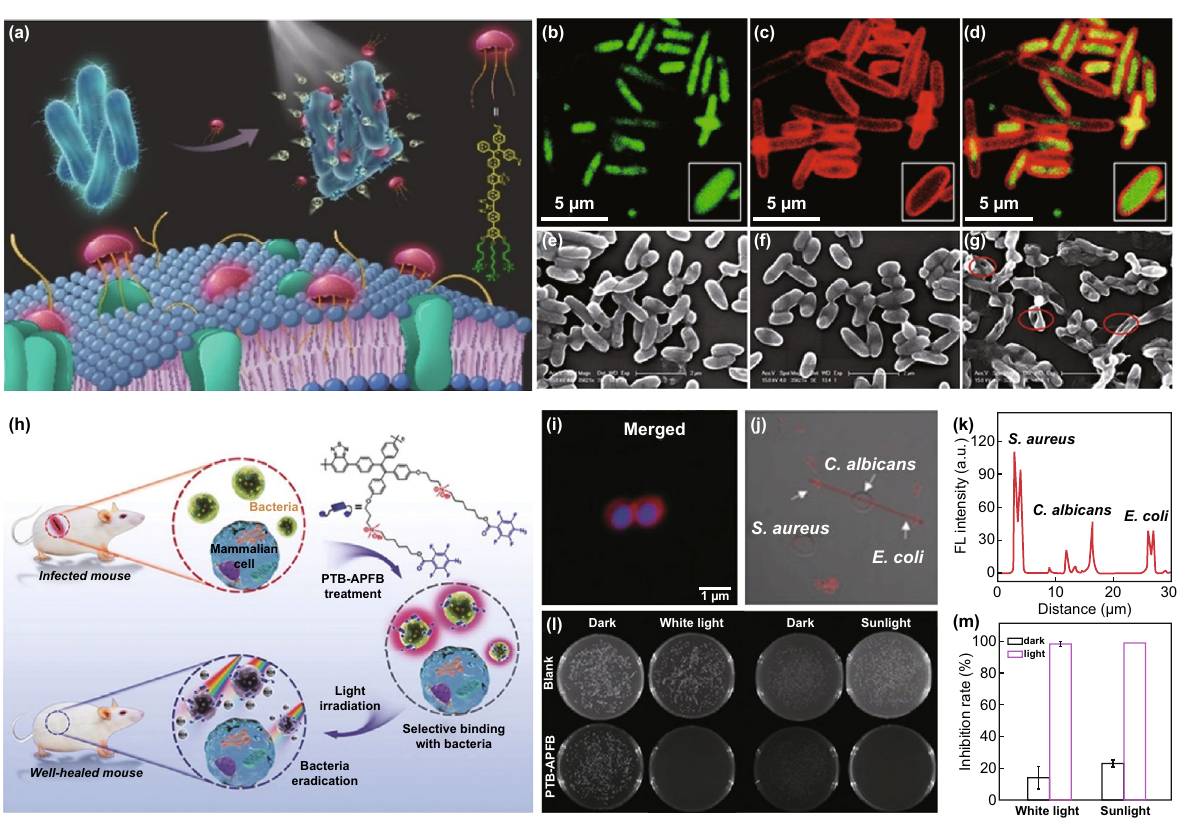
Fig. 5 a Chemical structure and schematic illustration of membrane-anchoring AIE photosensitizer for bacteria membrane penetration. Confo- cal laser scanning microscopy (CLSM) images of E. coli treated with 10 μM membrane-anchoring AIE photosensitizer and then labeled in b false green color by DAPI, c red color by photosensitizer, d yellow color by overlay images. Scanning electron microscopy images of e blank E. coli , f E. coli + 10 μM AIE photosensitizer under dark condition, g E. coli + 10 μM AIE photosensitizer under white-light irradiation [71]. Copy- right 2019 Wiley-VCH. h Chemical structure of PTB-APFB and its selective antibacterial application. i CLSM images of S. aureus incubated with PTB-APFB, followed with Hoechst 33342 co-staining. j CLSM images of PTB-APFB co-incubated with S. aureus, E. coli , and C. albicans . k Line scan analysis for the mixed sample. l Photographs of plate and m antibacterial activity of PTB-APFB against S. aureus in different